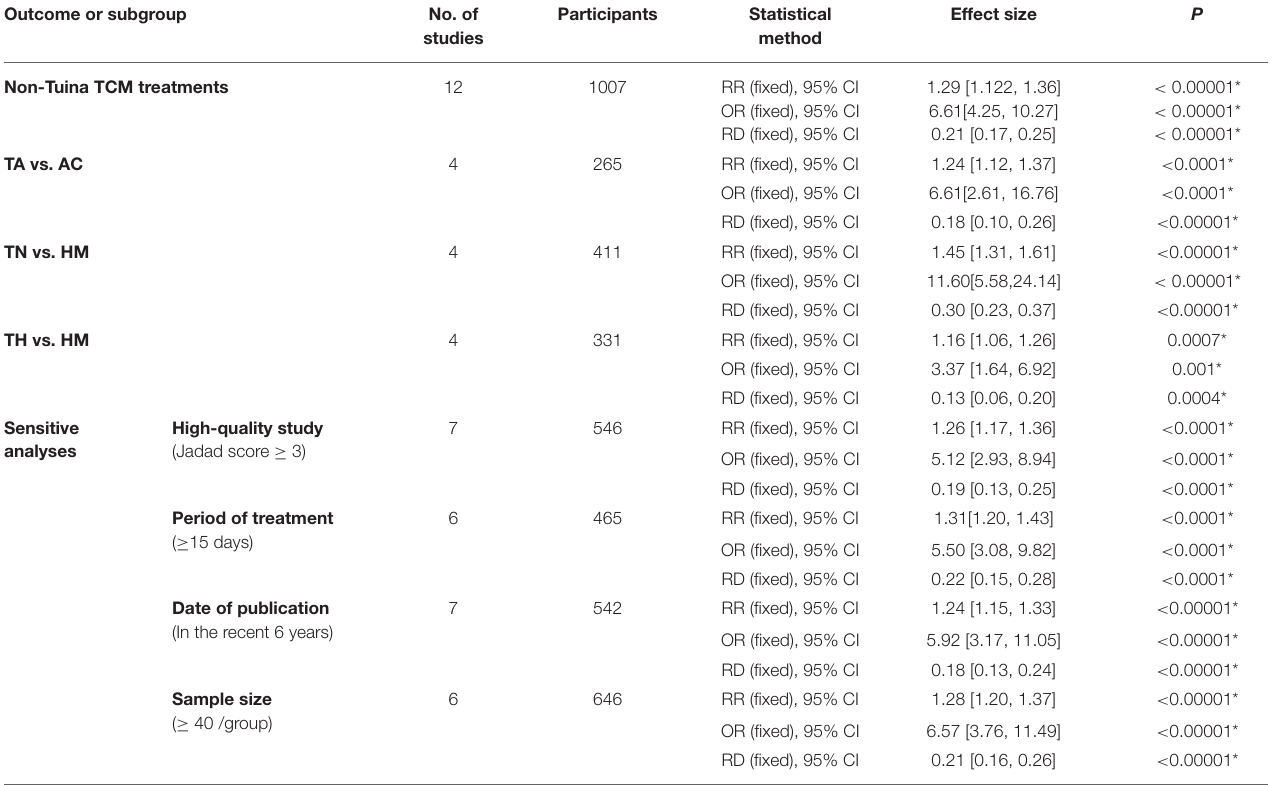
TABLE 2 | Summary of the meta-analysis (pooled data across categories in the control group). Outcome or